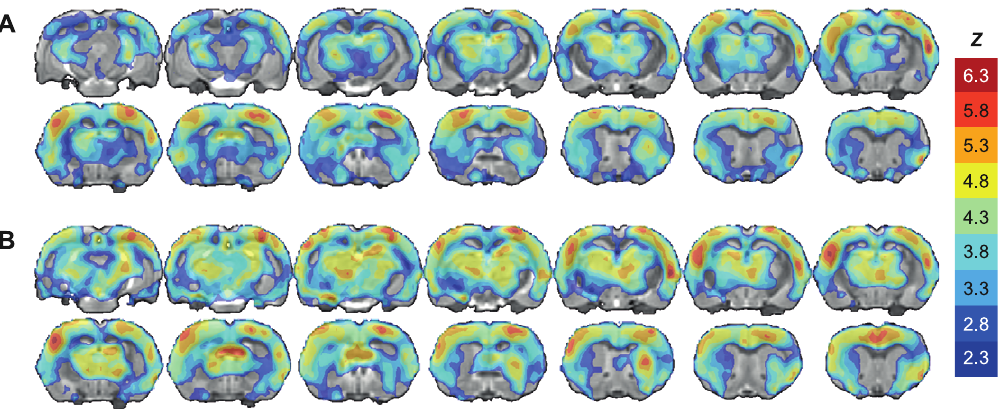
Figure 5. Cocaine-induced activation pattern from voxel-based analysis of pharmacological MRI. BOLD-based pharmacological MRI was performed for 50 minutes, with 1 mg/kg cocaine injected intravenously after 10 minutes. The maps display the group-level results from a voxel- based analysis of cocaine-induced brain activation, obtained from second-level analysis of subject-level generalized least squares fits of the pharmacological MRI signals in (A) 5-HTT + / + , and (B) 5-HTT -/- animals. The maps display Z -values of significantly activated voxels ( p , 0.01, cluster- corrected). Positive responses are color-coded between Z = [2.3, 6.3], and overlaid on a multi-slice anatomical rat brain template.